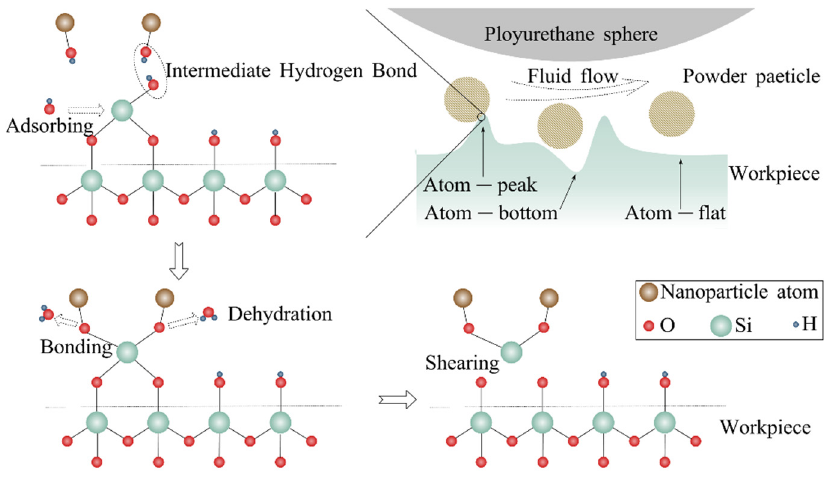
Figure 22. The interactions between workpiece surfaces of ultra-fine powders and works [165,167].